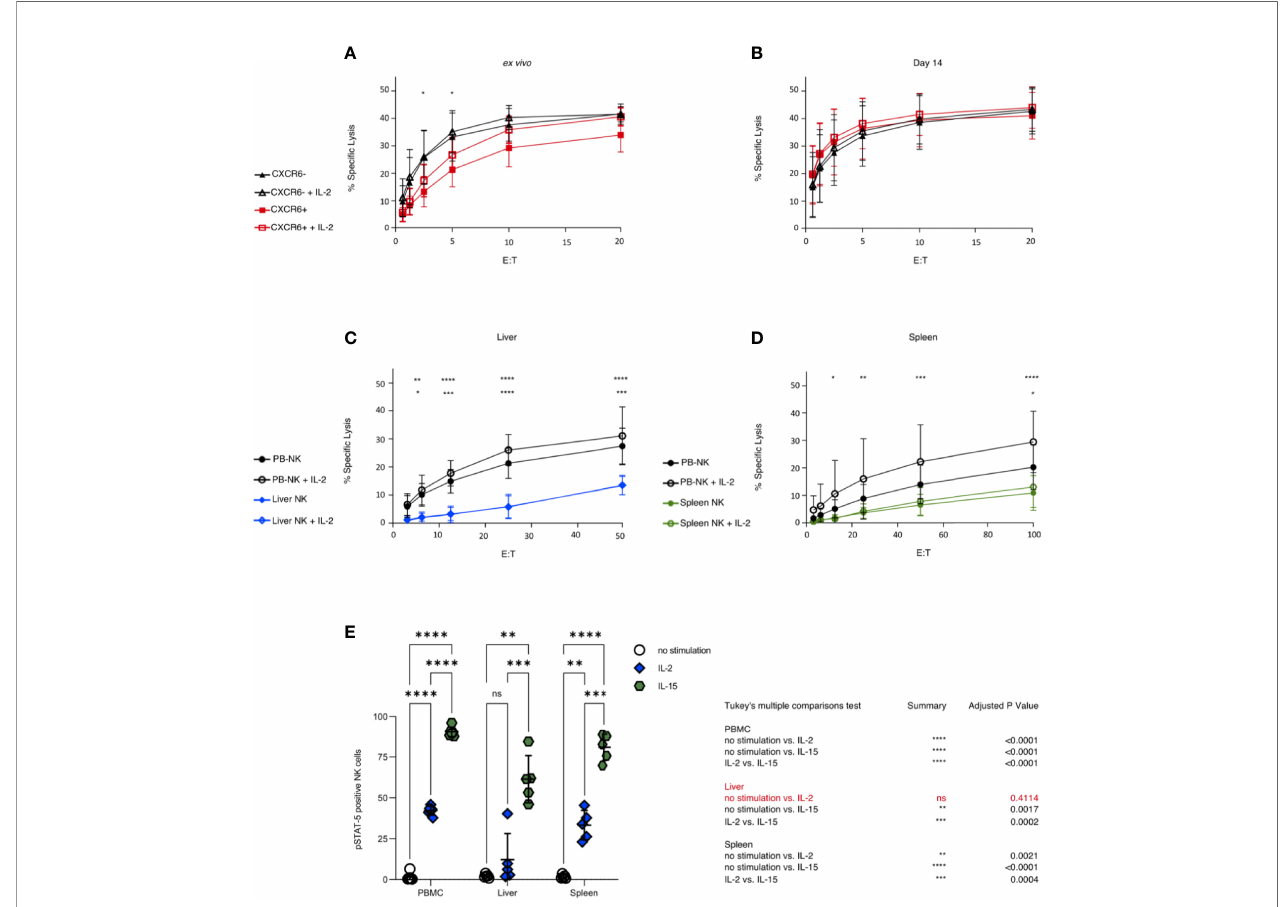
FIGURE 5 | PB-NK cells show higher cytotoxicity against K562 than liver and spleen NK cells, and CXCR6 + PB-NK cells are functionally equivalent to CXCR6 - PB- NK cells after 14 days in culture. Sorted CXCR6 - and + NK cells were used as effectors starting at a 20:1 effector to target ratio (E:T). Percent speci fi c lysis is shown as a function of E:T. All assays were run in duplicate or triplicate. (A) Freshly sorted CXCR6 - NK cells possess a higher cytotoxic function against K562 than CXCR6 + NK at lower E:T ex vivo ( n=5 ). (B) CXCR6 - and CXCR6 + NK cells are virtually identical in their ability to kill K562 targets by 14 days post-activation in culture ( n=10 ). (C) Unsorted ex vivo bulk liver lymphocytes have low cytotoxic capability against K562 and are unresponsive to IL-2 ( n=5 ). Mean of 42% NK cells in bulk liver cells (range 22-61%) (D) Bulk spleen lymphocytes also exhibit low cytotoxicity against K562 but are slightly responsive to IL-2 at higher E:T ratios ( n=8 ). Mean of 11.4% NK cells in bulk spleen cells (range 7-14%). Two-way ANOVA with Tukey ’ s multiple comparison test was used to compare cytotoxic effector function. P values are as described in Figure 1 . The top row of p values designates signi fi cance between CXCR6- and + (A, B) or between PB and liver or spleen (C, D) . The bottom row of p values is within each tissue plus or minus IL-2. For complete statistical analysis, see Supplementary Table 6 . (E) Liver NK cells (CD45 + , CD56 + , CD3 – ) are virtually unresponsive to IL-2 stimulation as measured by STAT5 phosphorylation. Phosphorylation of STAT5 in bulk NK cells in PB, liver, and spleen following stimulation with IL-2 (10 ng/mL) (blue diamonds) or IL-15 (50 ng/mL) (green hexagons) ( n=5 ). Tukey ’ s multiple comparisons test was used to determine signi fi cance between no stimulation (open circles) vs IL-2 or IL-15 treatment, or IL-2 vs IL-15. p < 0.05 was considered signi fi cant. (*p < 0.05; **p < 0.01; ***p < 0.001; ****p < 0.0001; ns, not signi fi